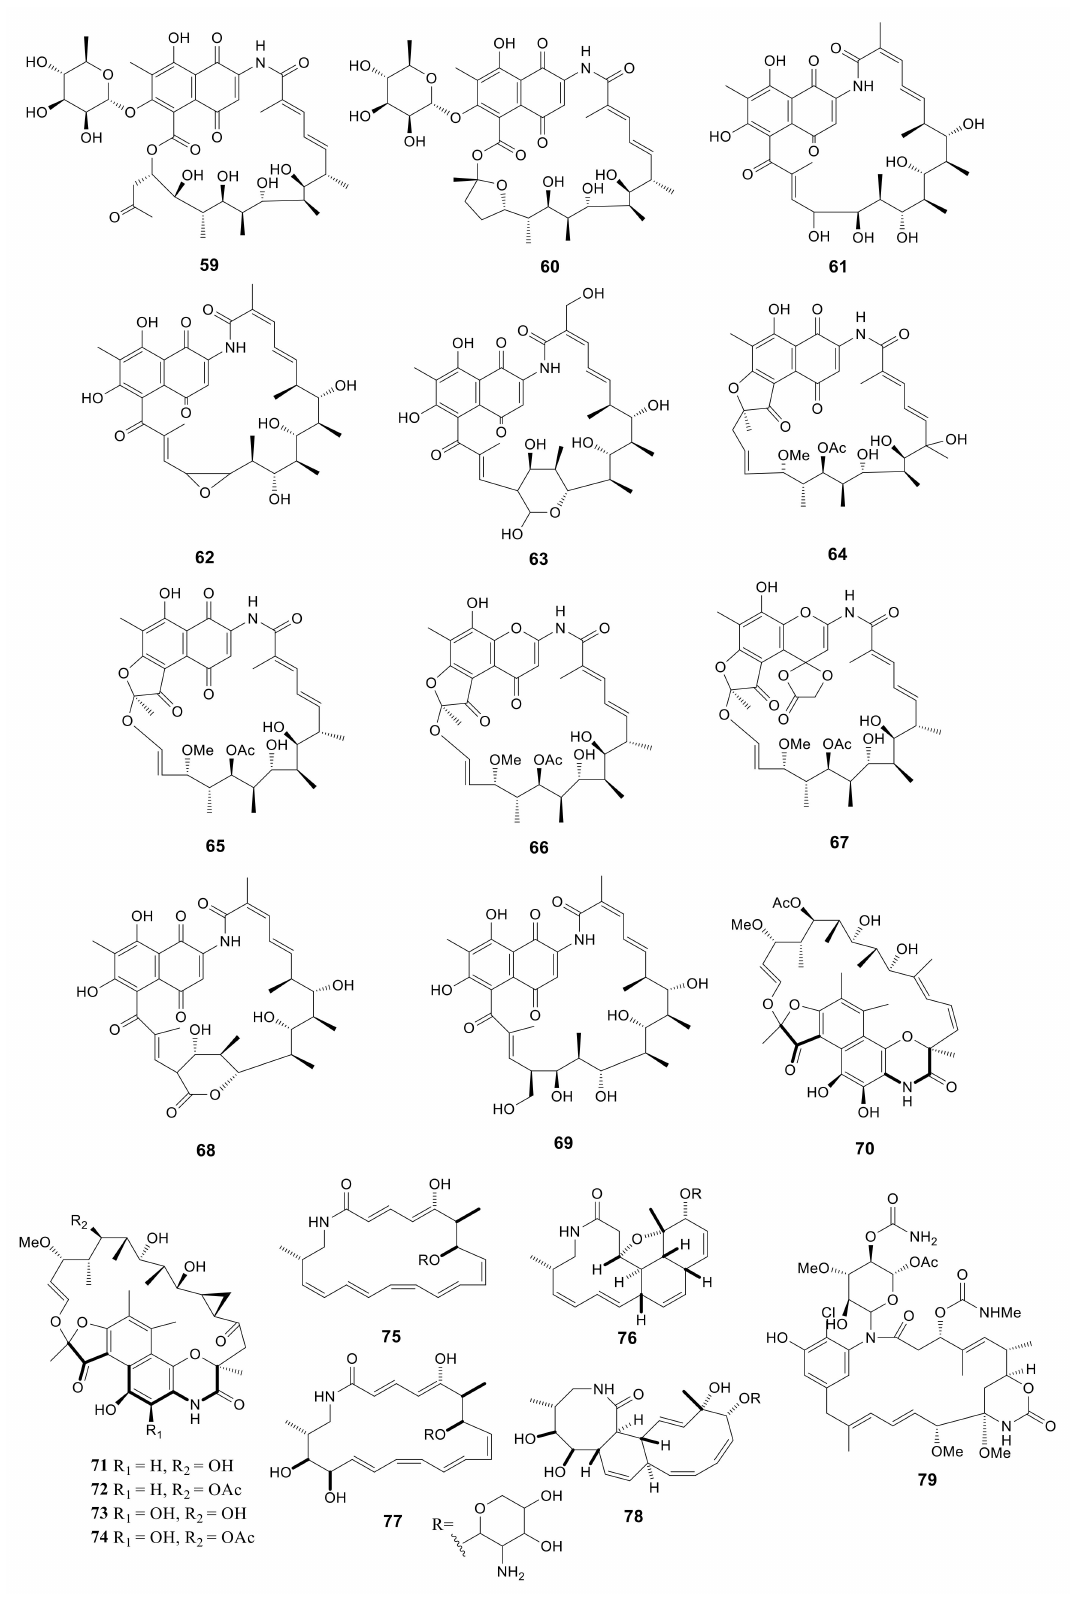
Figure 3. Structures of macrolactams ( 59 – 79 ) from Amycolatopsis